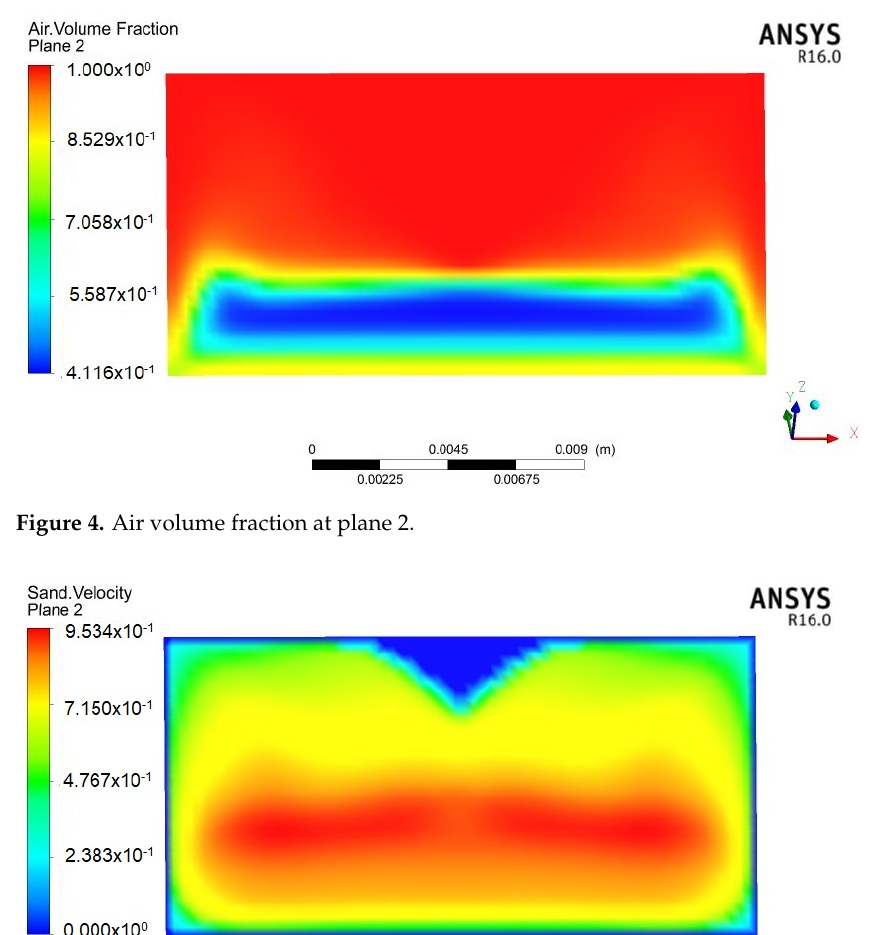
Figure 3. Air velocity at plane 2.